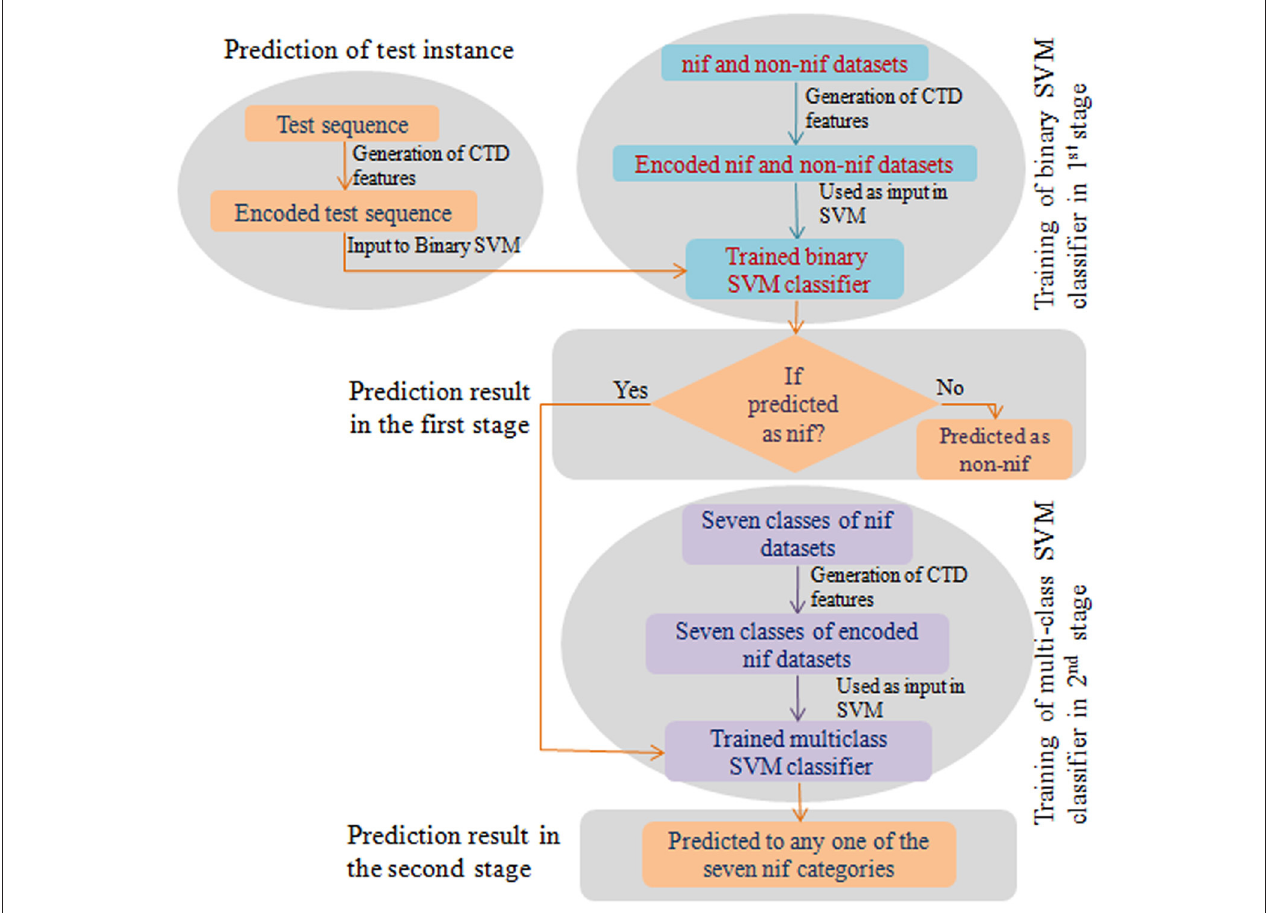
FIGURE 1 | Flow diagram of the prediction process. This diagram shows the steps involved in construction of a binary and multiclass classifiers and the prediction of the test instance in two